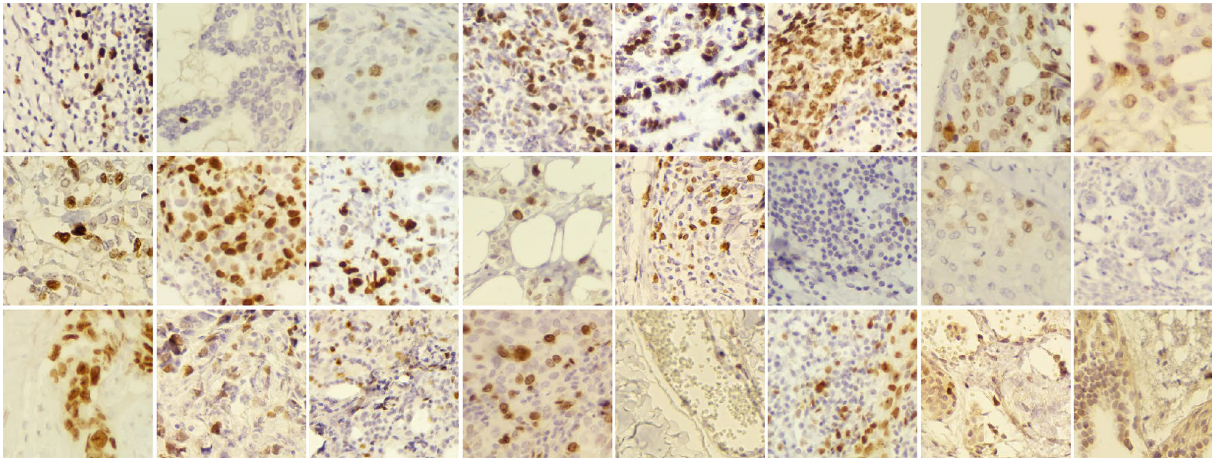
Figure 1. SHIDC-B-Ki-67 dataset